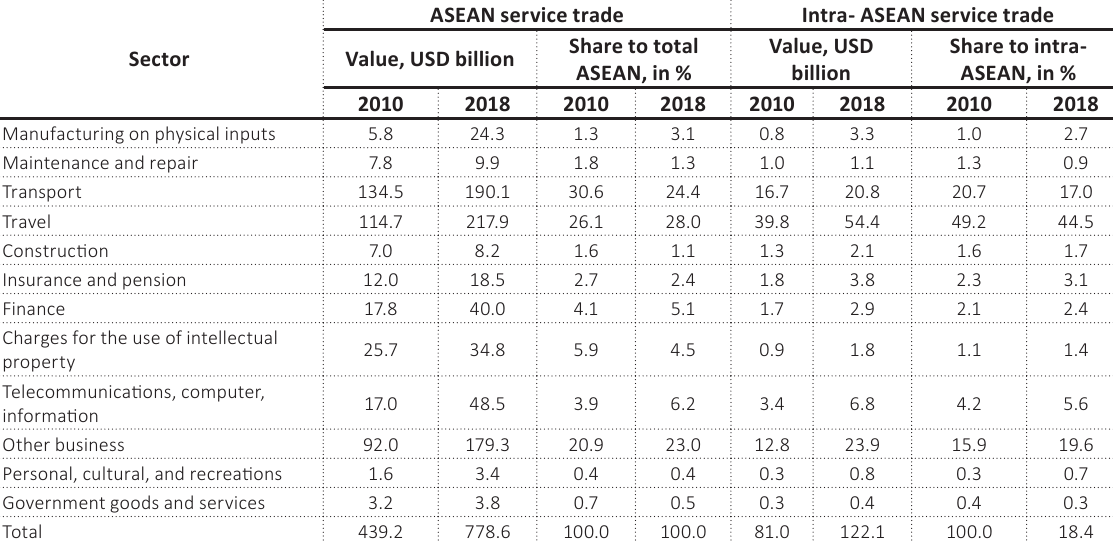
Source: Menon et al.